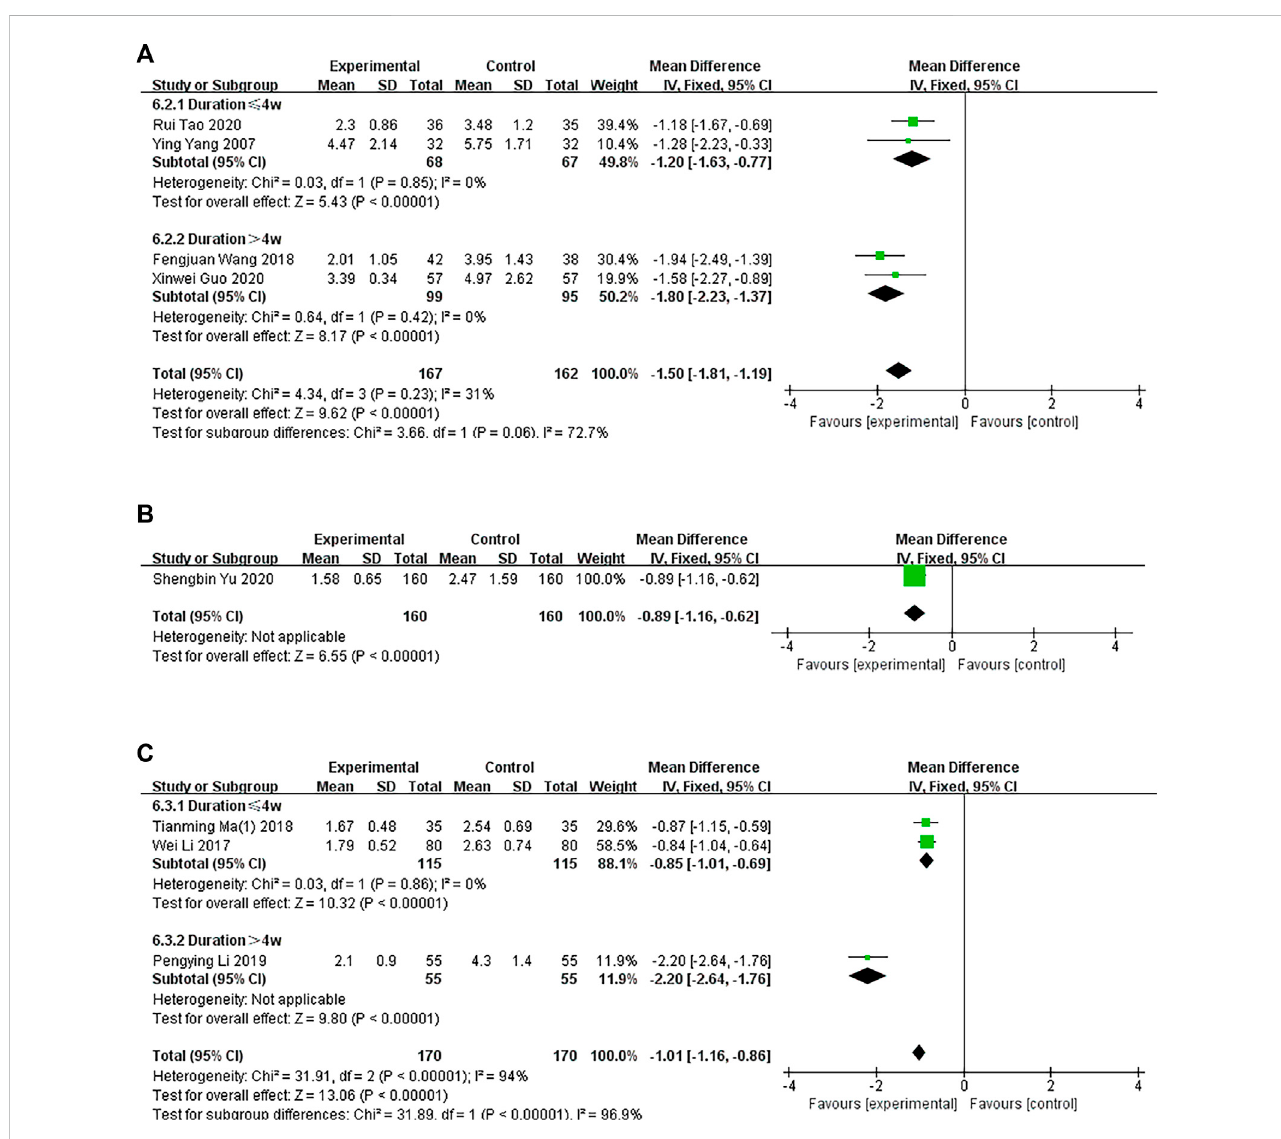
FIGURE 5 The results of themeta-analysis for theeffect oftraditional Chinese medicineversusWestern medicineon pruritus. (A) Oral CHM treatment; (B) External treatment with CHM; (C) Oral and external treatment with CHM.